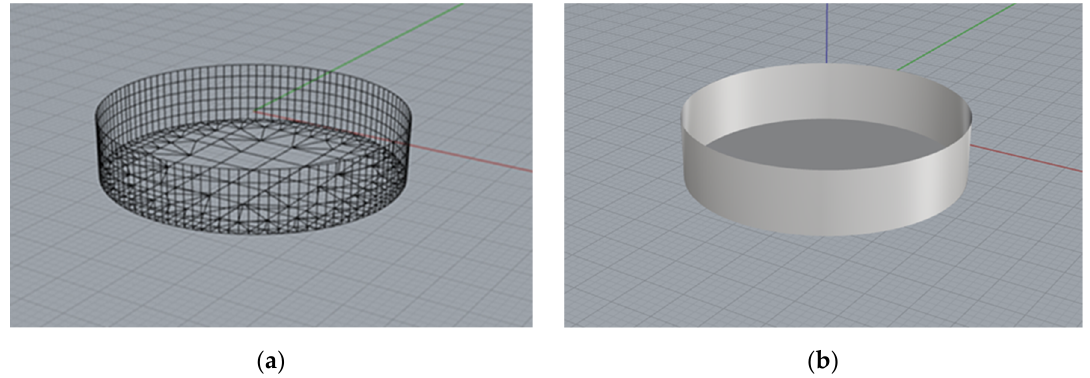
Figure 1. The numerical model of the vertical cylinder: ( a ) Description of the vertical cylinder; ( b ) Numerical panel of the vertical cylinder.